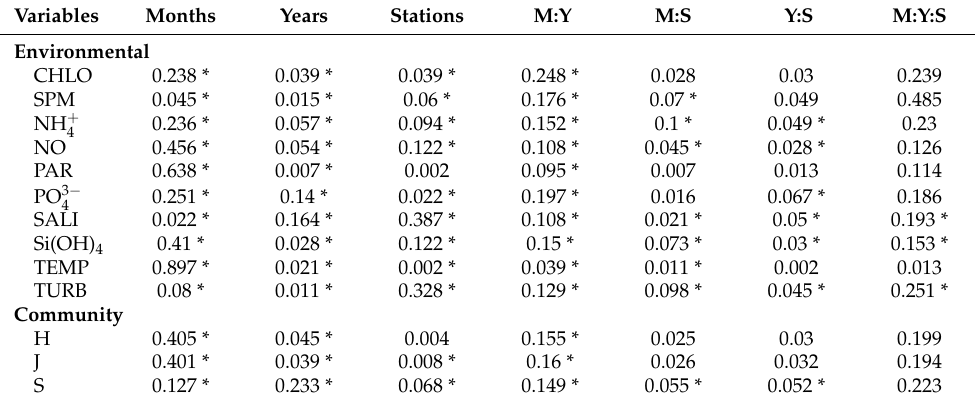
Table 2. A summary of the PERMANOVAs performed on the environmental (SPM, suspended particulate matter; NH 4+ , ammonium concentration; NO, nitrate + nitrite concentration; PAR, pho- tosynthetic active radiation; PO 4 3 − , phosphate concentration; TEMP, temperature; SALI, salinity; Si(OH) 4 , Silicate concentration; TURB, turbidity and CHLO, the concentration of chlorophyll- a )) and community diversity variables (H, Shannon diversity index; J, Pielou’s evenness and S is the total number of species) with the month, year, and station as a single or combined (M: Months, Y: Years and S: Stations) explanatory factor. For each factor, the R 2 are given and the significance is represented by the * ( p value <